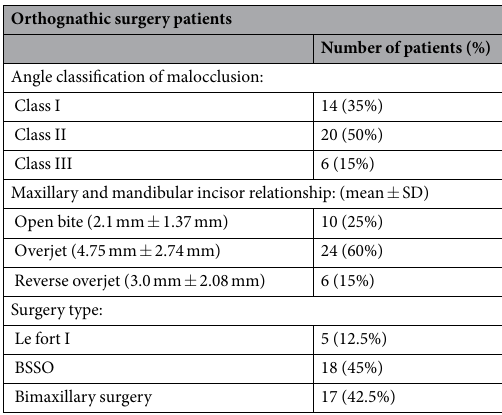
Table 1. Malocclusion and surgical characteristics of the orthognathic surgery patients included in the